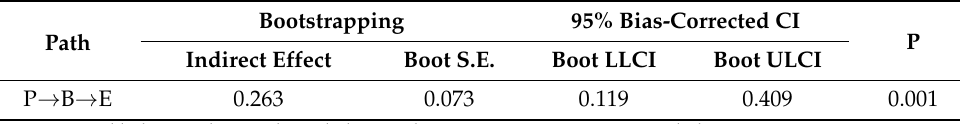
Figure 2. The structural equation modeling (SEM). (Note: ** p < 0.001). Table 4. Mediation test using bootstrapping.